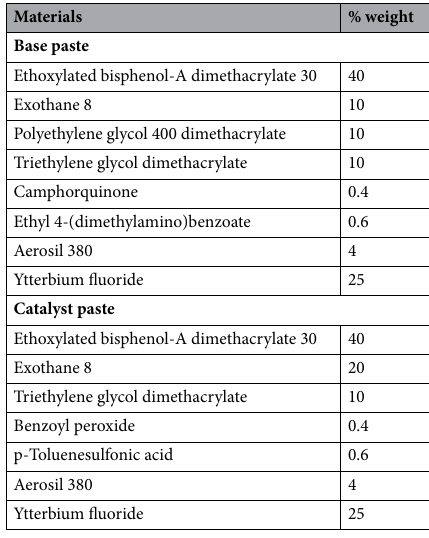
Table 1. Composition of the experimental endodontic